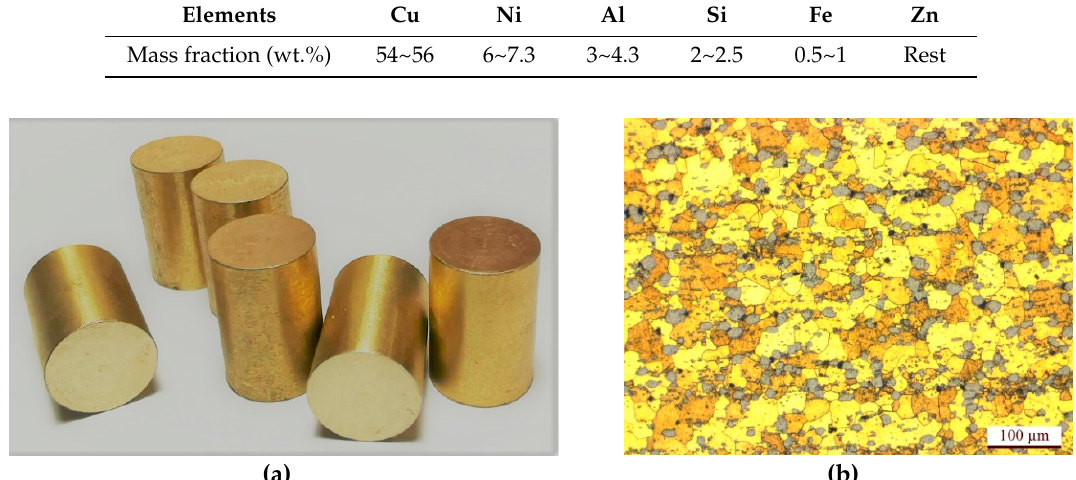
Table 1. Chemical composition of Cu-Ni-Al nickel brass alloy (mass fraction, %) Elements